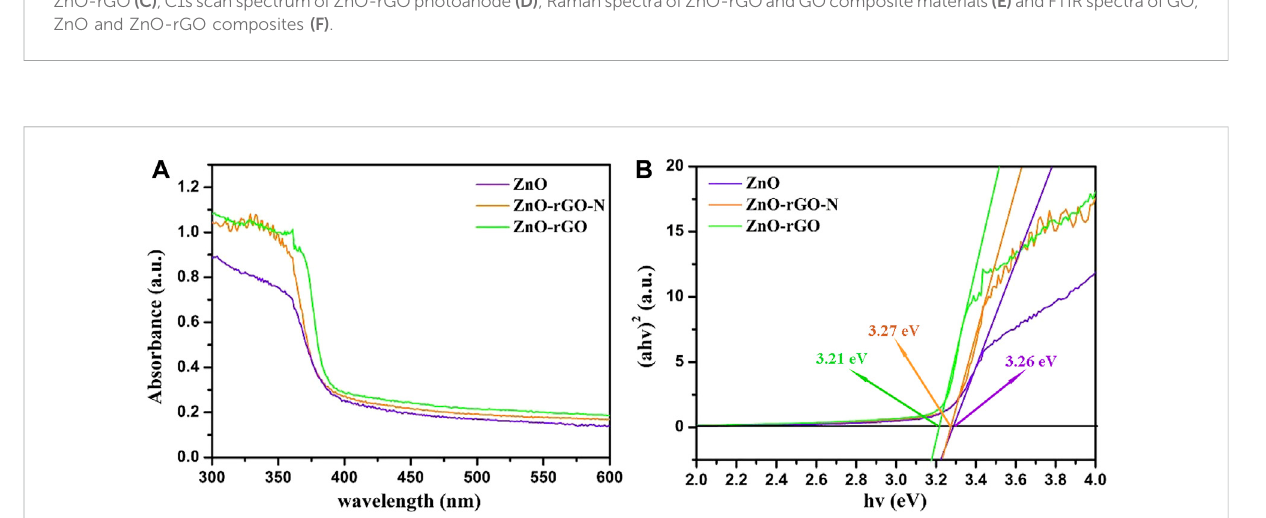
FIGURE 4 UV-vis absorption spectroscopy of ZnO, ZnO-rGO-N and ZnO-rGO composite materials (A) and thecorresponding curves of( α hv ) 2 versus the hv (B) .